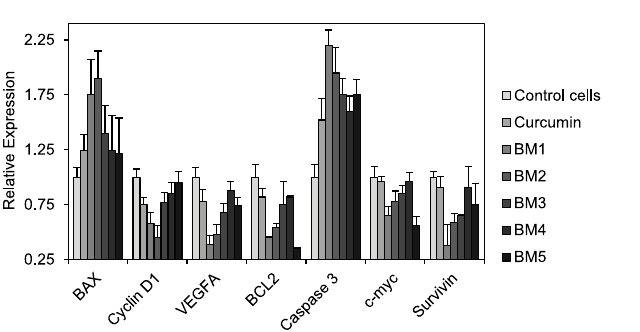
Figure 7. Relative expression levels of Bax, cyclin D1, VEGFA, Bcl-2, Caspase 3, c-myc, survivin and RPL38 mRNA in AGS cells. All Ct values were normalized with the homo sapiens ribosomal protein L38 (RPL38) as a housekeeping